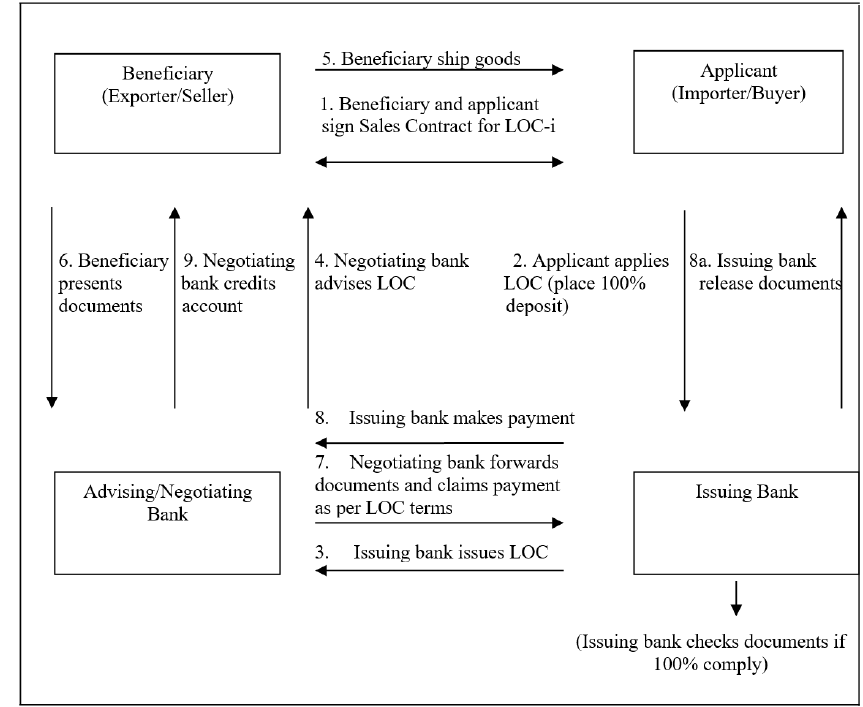
Figure 3. The process flow of the operation of LC Wakalah.